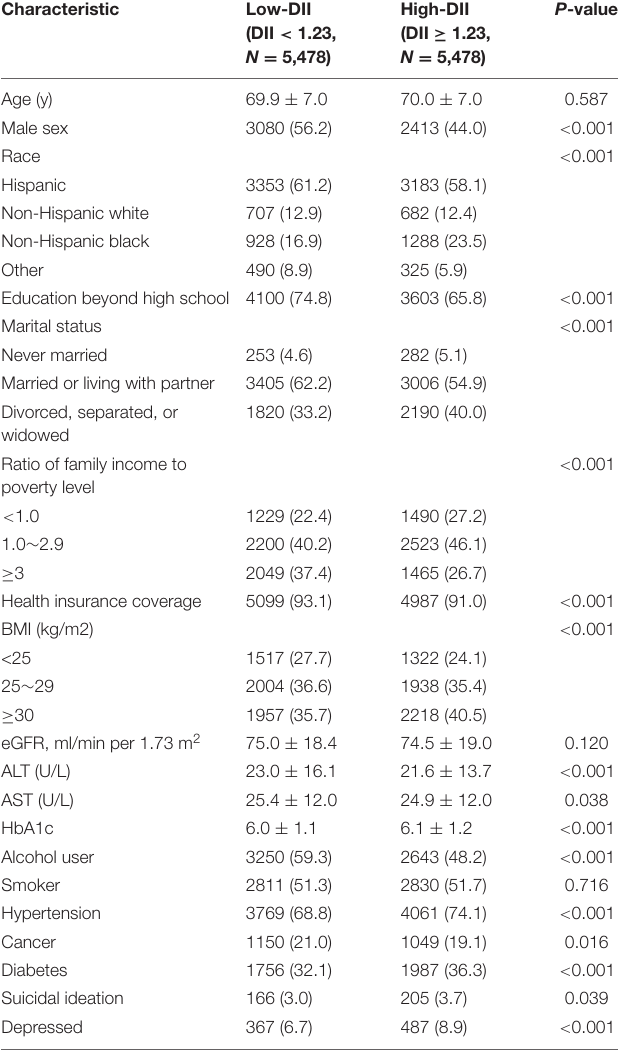
High-DII group than in the Low-DII group, and the differences were statistically significant ( P < 0.05).